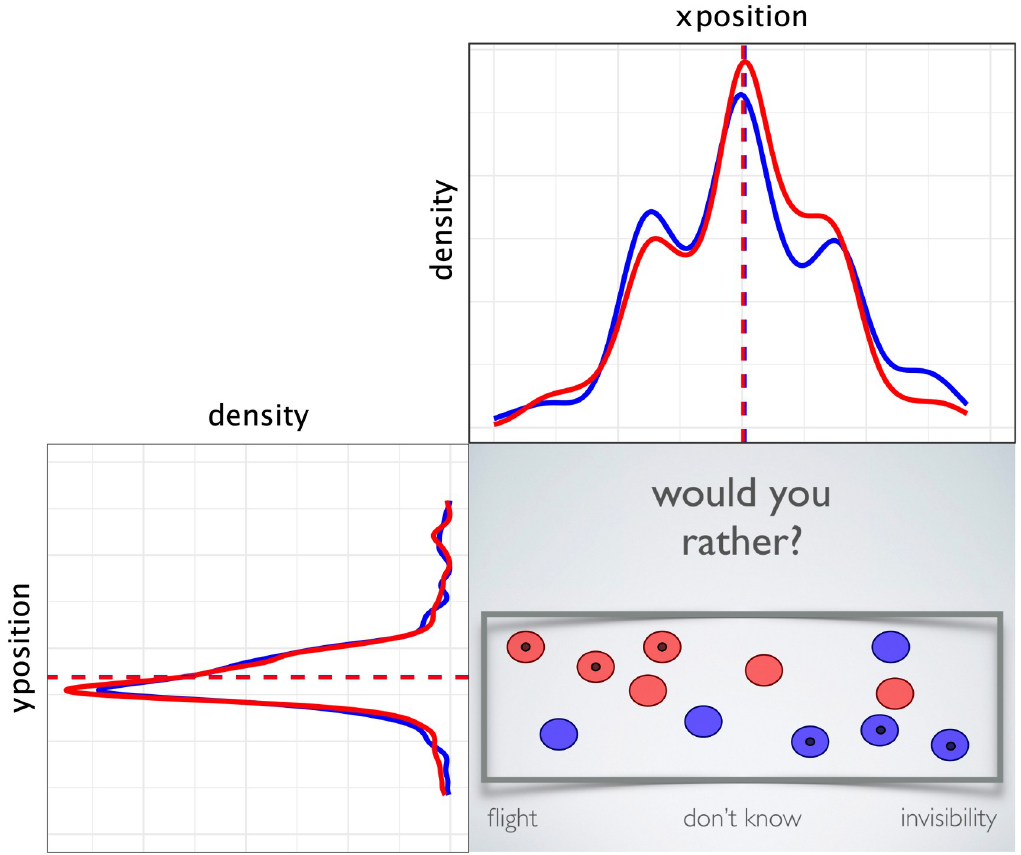
Fig 3. Example of the final stage of a preference trial. Confederate dots, identified with a dark spot, clustered in corners of the response box. Density plots show participants’ final vertical (shown left) and horizontal (top) dot positions. The ‘rather’ task used images to illustrate ‘flight’ and ‘invisibility’ which have been removed here for copyright